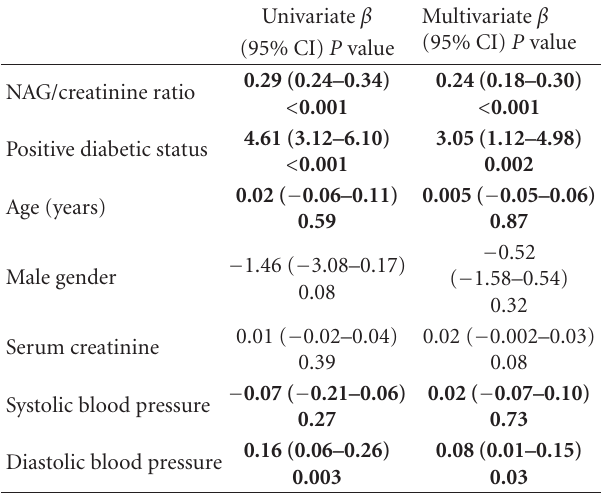
Table 2: Univariate and multivariate regression models for factors associated with urinary albumin/creatinine